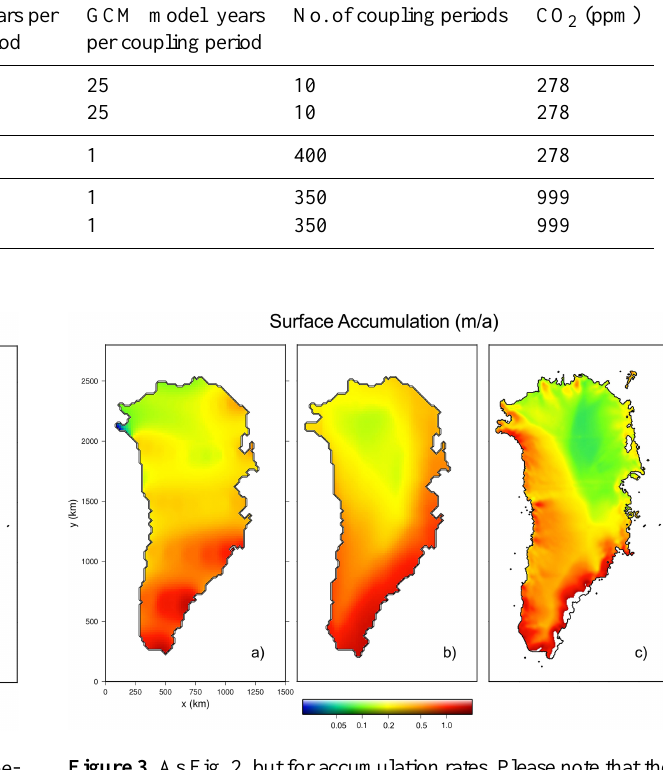
Figure 2. Ablation pattern of the initial forcing over Greenland be- fore ( a , Exp. 1a) and with ( b , Exp. 1b) the downscaling procedure. For reference, we also plot data from a regional climate model ( c , Ettema et al., 2009). The scale is logarithmic; this is also the cause for the white area in plot (c) as the values are too close to zero to be represented on this scale.